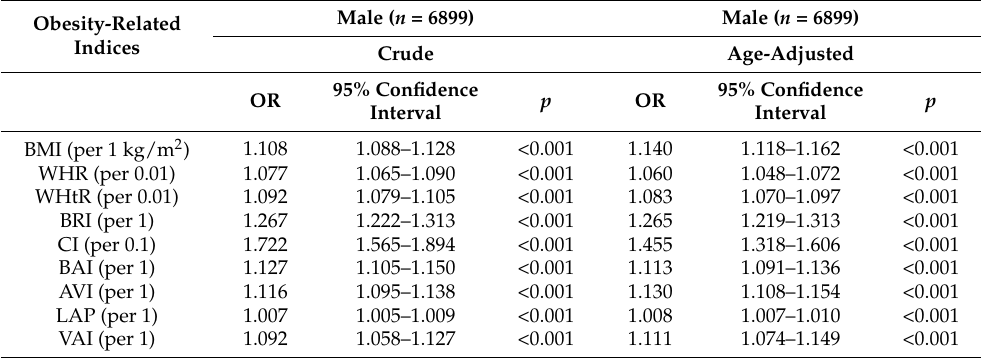
Table 3. Association of obesity-related indices with incident hypertension using univariable and age-adjusted logistic regression analysis in male participants.